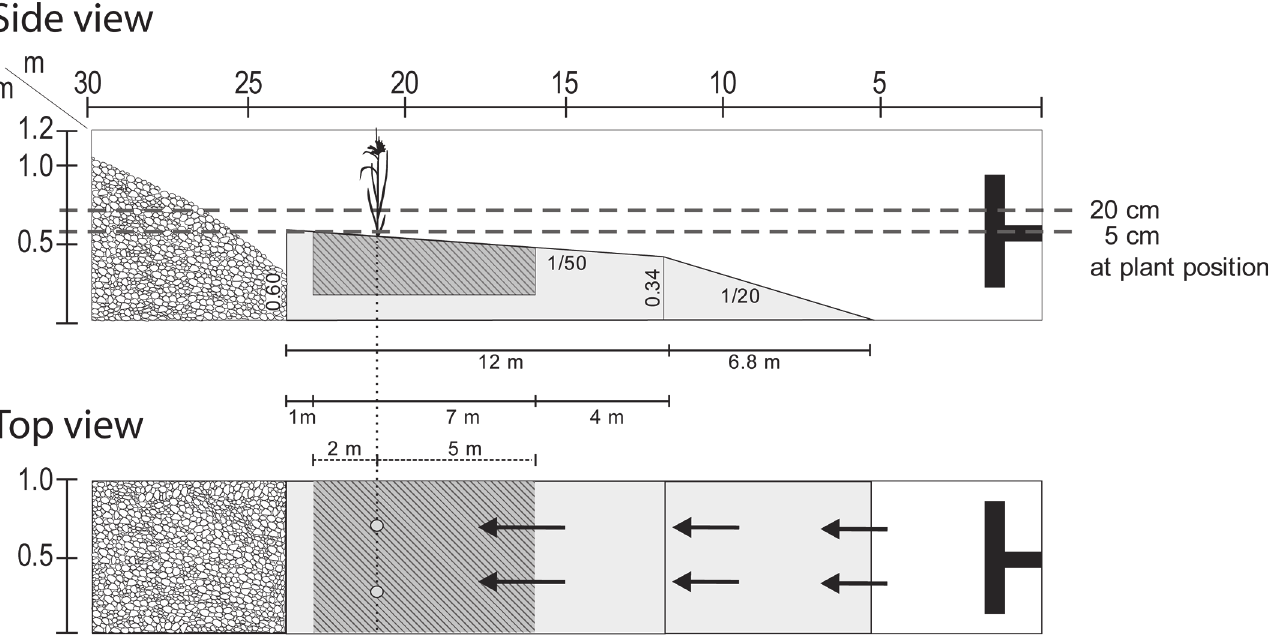
Fig 1. Sketch of physical model in the wave flume. Top: side view; bottom: top view. The position of plants is indicated by the schematic plant on the top panel and by two light grey circles in the bottom panel. The light grey bodies are the 1/20 transition slope and the 1/50 slope of the test section which were built of smooth concrete plates. The sediment box (hatched part of the test section) was filled with natural sediments from the Scheldt Estuary (SW Netherlands). The absorption beach (left end of the flume) was built of pebble stones. The horizontal grey dashed lines (top) represent the two tested water levels (20 and 5 cm water depth at plant position). The black arrows (bottom) represent the direction of propagation of waves produced at the wave paddle (black structure on the right end of the flume).